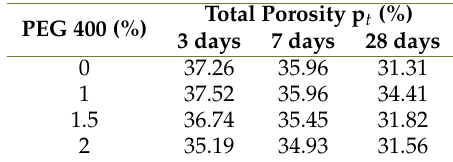
Table 6. Total Porosity at 0.34 Water-Cement Ratio.